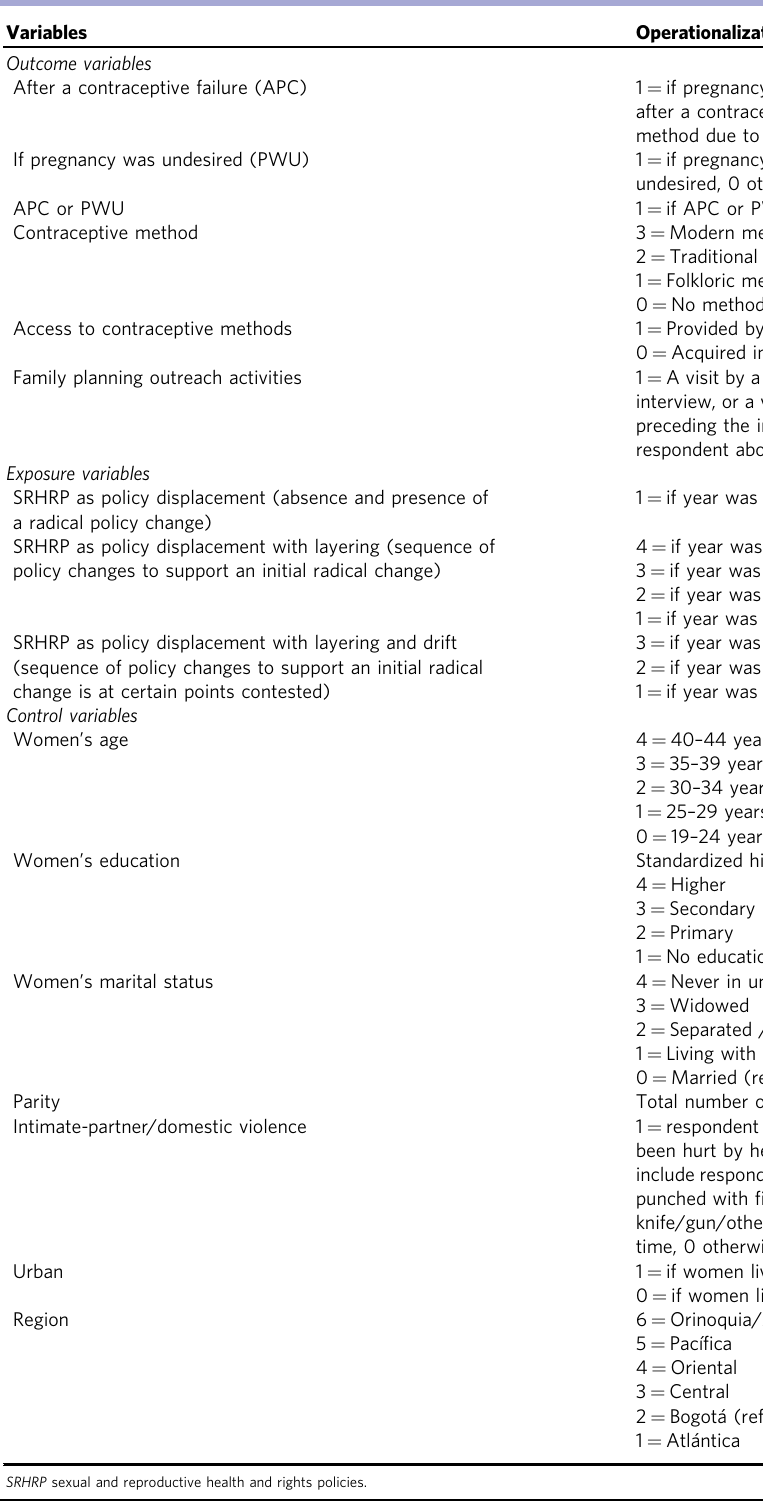
Table 1 Description of the main